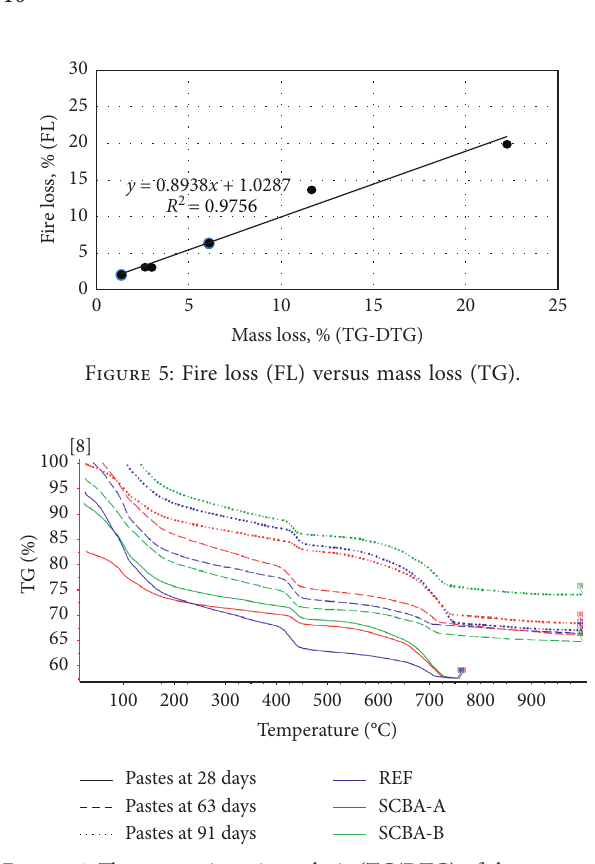
Figure 6: Thermogravimetric analysis (TG/DTG) of the pastes at 28, 63, and 91